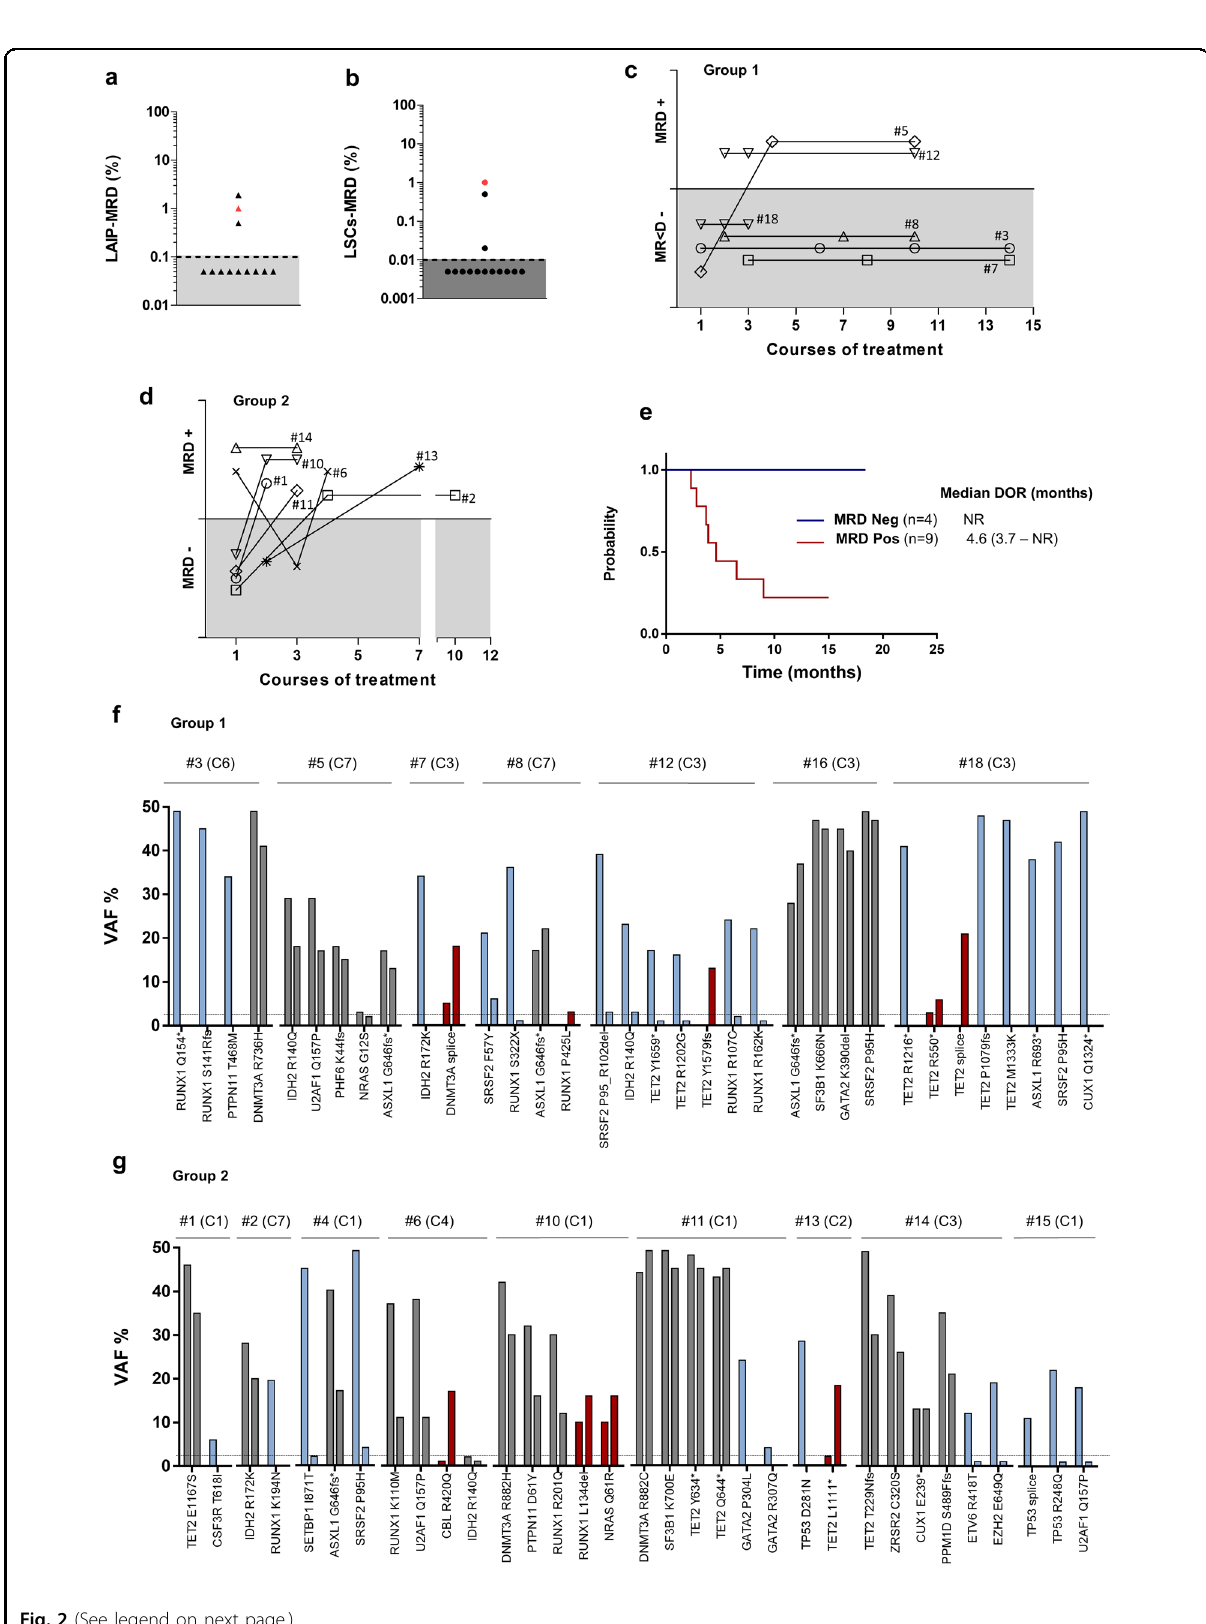
Fig. 2 (See legend on next